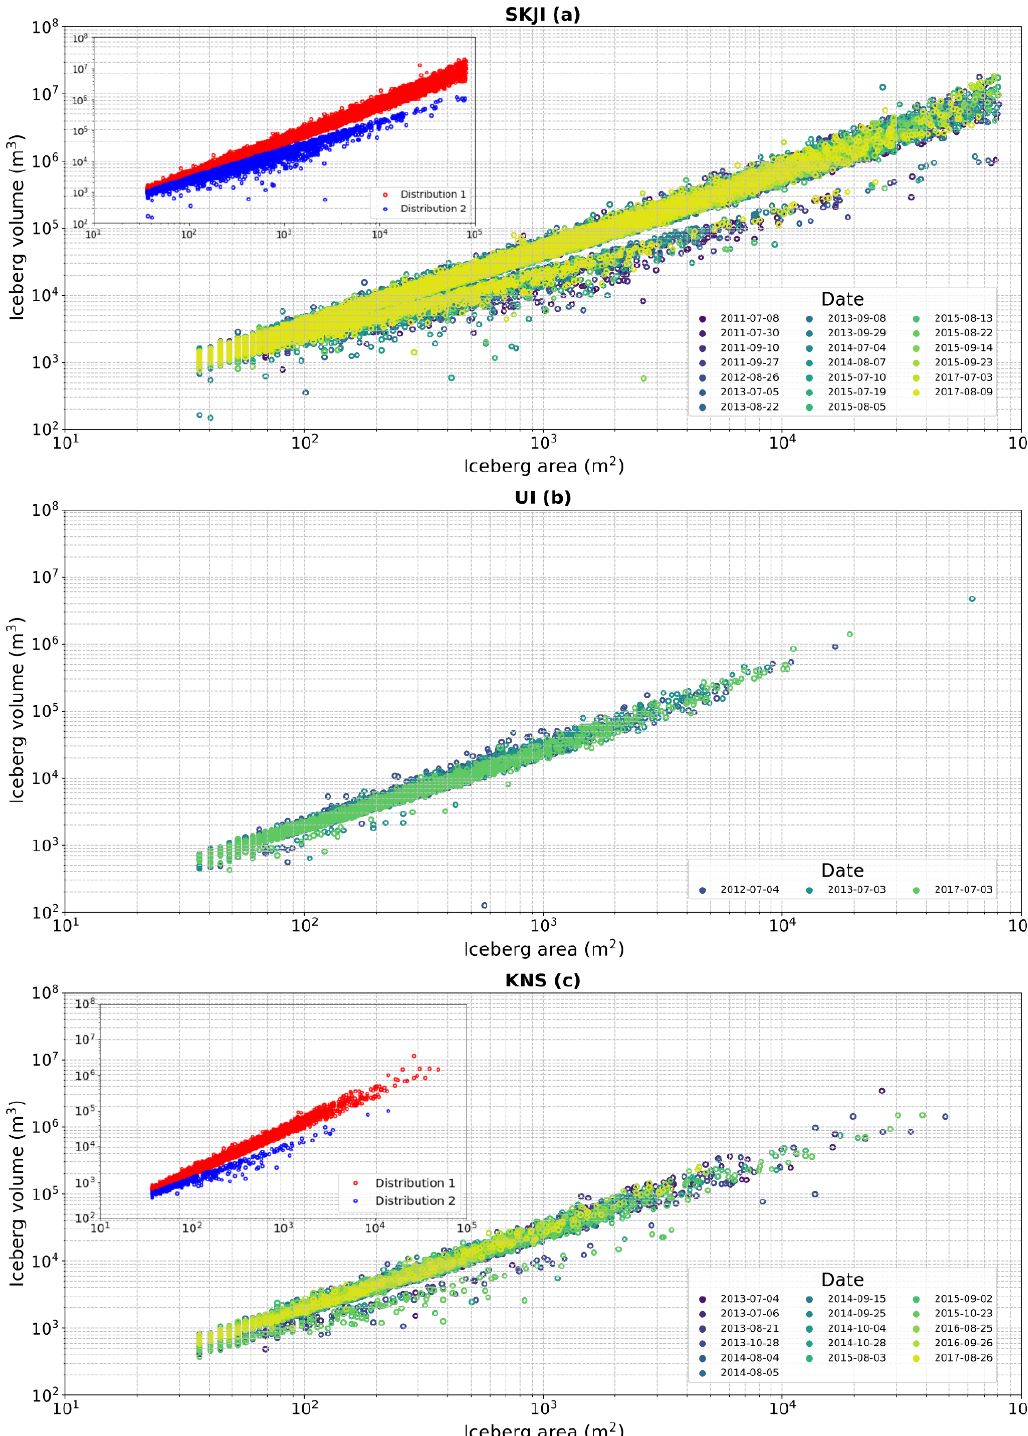
Figure 8. Iceberg area versus volume which is colour coded by each ArcticDEM scene date. The inset in both the SKJI (a) and KNS (c) panels shows the two distributional branches identified in the data. Each distribution is separated by identifying local minima in probability distribution histograms of the entire